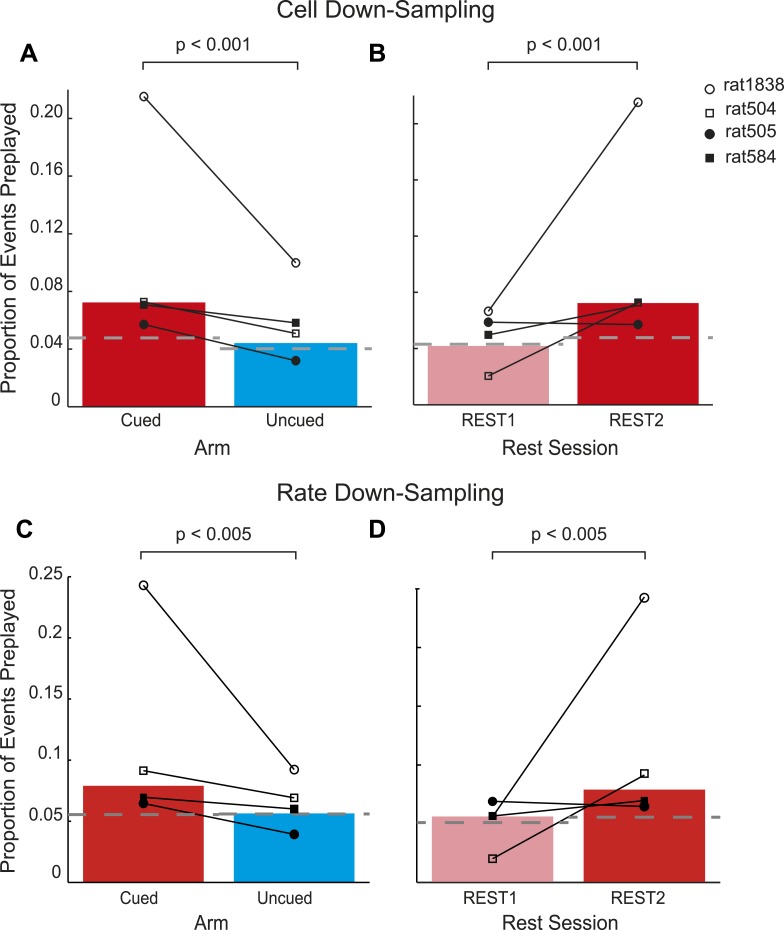
Preferential preplay of the cued arm is not confounded by the number and activity of cells on the cued arm.(A) Proportion of preplay events for the cued and uncued arm in REST2 following down-sampling to equate the number of cells on the two arms. Bars show means, black lines the results for individual animals and the dashed grey lines the proportion of preplay events expected by chance. (B) same as a but comparing the proportion of preplay events for the cued arm in REST1 and REST2. C–D same as A–B but following down-sampling to equate firing rates during rest.